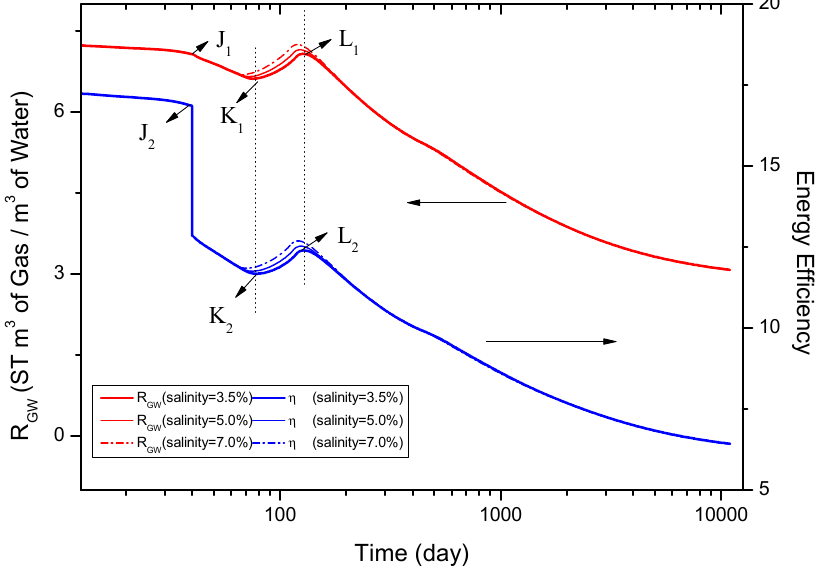
Figure 5. Evolution of the energy efficiency η , the gas-to-water ratio R dependence on the salinity of the injected brine during hydrate